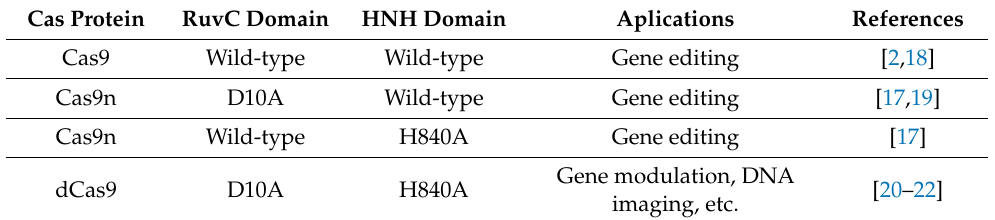
Table 2. Cas9 and the mutated variants used for gene editing and gene modulation.